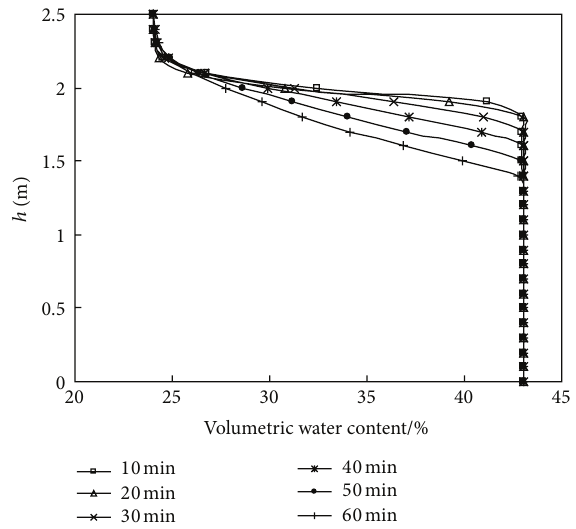
Figure 3: Variation of subgrade moisture in the falling course of groundwater